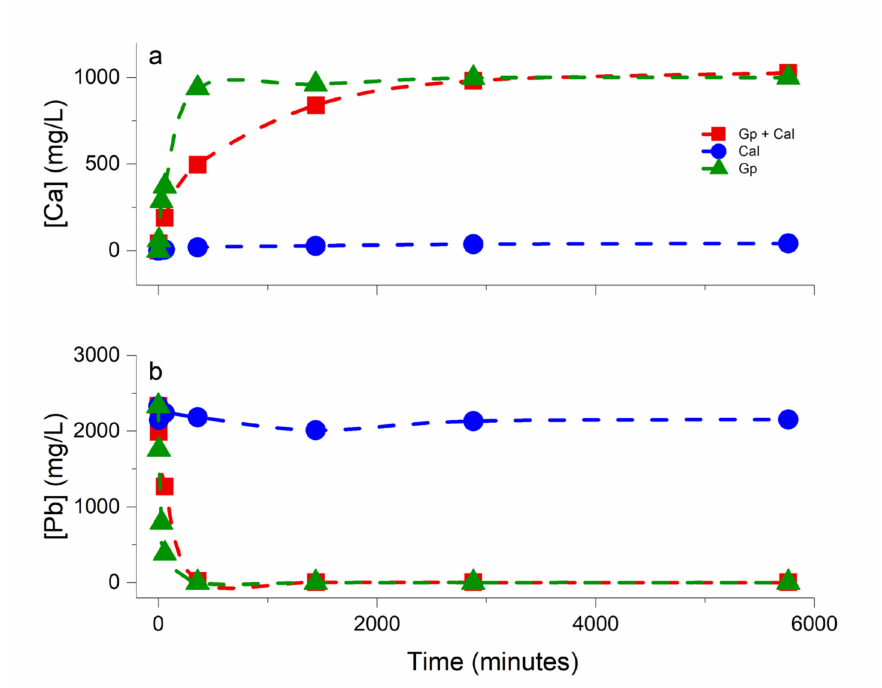
Figure 2. Evolution of Ca ( a ) and Pb ( b ) concentration as a function of time for interaction experiments carried out with [Pb] i = 10 mM. The drop in Pb concentration ( b ) closely mirrors the release of Ca ( a ) to the aqueous solution when the latter interacts with gypsum (Gp). The interaction with calcite (Cal) leads to a very slow [Ca] increase ( a ) and [Pb] drop ( b ) in the aqueous solution. Finally, during the interaction with mixtures of gypsum and calcite (Gp + Cal) [Ca] continues to increase ( a ) after [Pb] drops to a steady value ( b